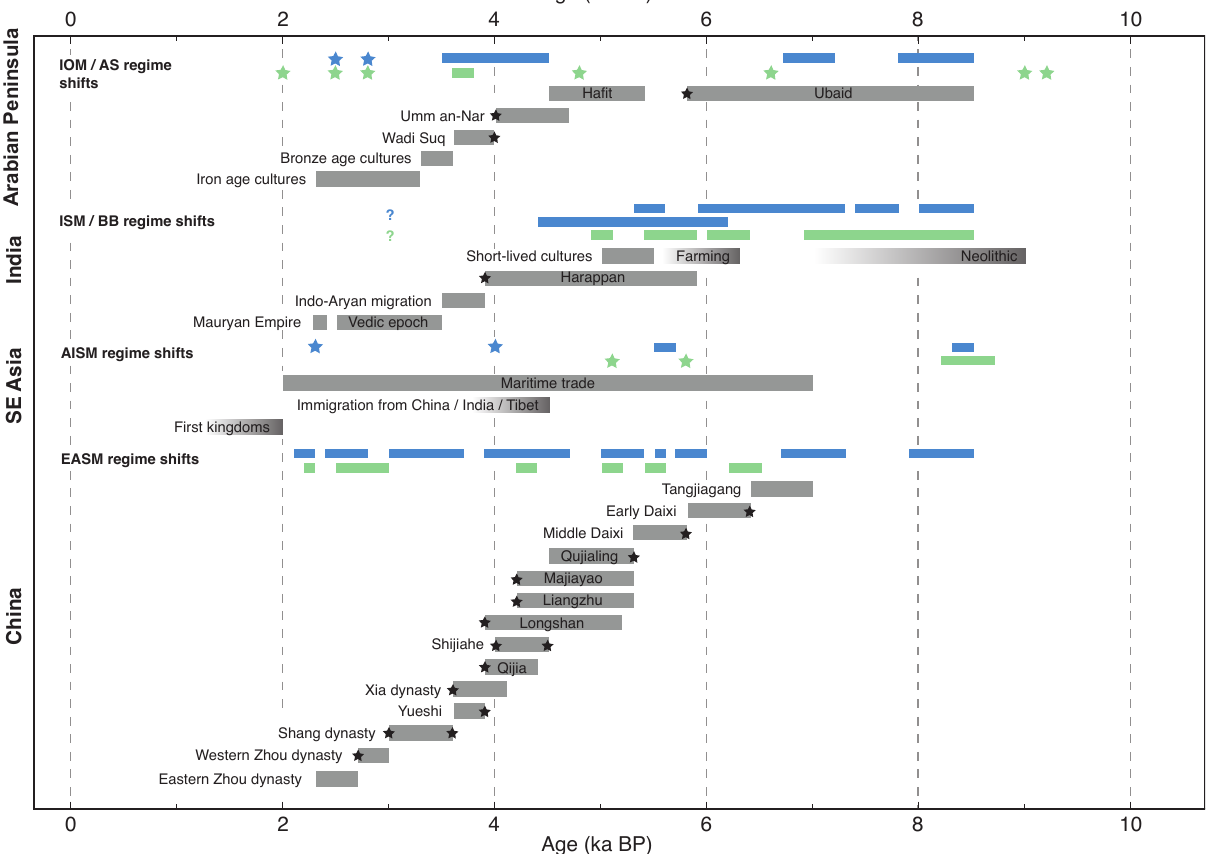
Figure 11. Regional monsoonal regime shifts relative to cultural change and migratory events in the Arabian Peninsula, India, south-east Asia, and China during the mid-to-late Holocene. Non-linear regime shifts revealed by the RN measures average path length and transitivity are indicated by blue and green bands (extended shifts > 100 years) and stars (short shifts < 100 years), respectively. These episodes are obtained by regionally aggregating the results presented in Figs. 7 and 8, assigning cave records to different monsoon branches as in Table 1. For the region of India, question marks signal a lack of data from suitable published speleothem palaeoclimate records for the time after 4kaBP. Reported abrupt establishments or terminations of human cultures are marked by black